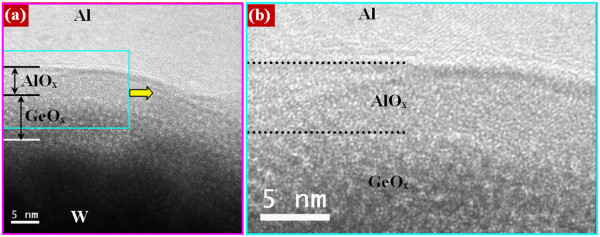
TEM images of the device using Al electrode. (a) HRTEM image of an Al/GeOx/W cross-point memory. (b) Formation of an AlOx film with a thickness of approximately 5 nm at the Al/GeOx interface is observed.